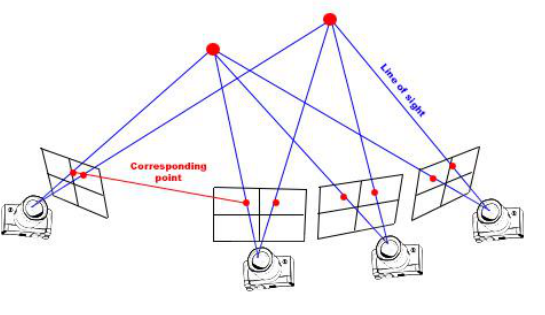
Figure 13. Illustration of Bundle Adjustment in